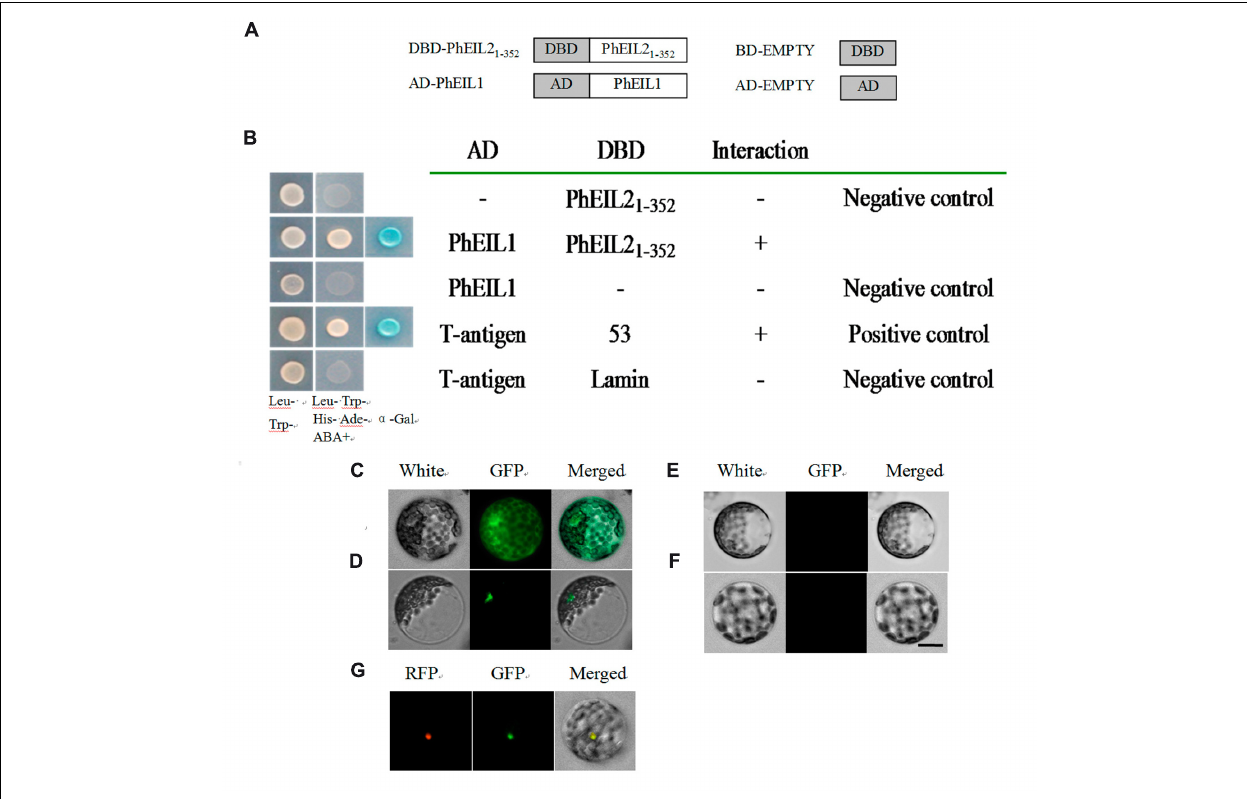
FIGURE 7 | Interaction between PhEIL2 1 − 352 and portions of PhEIL1. (A,B) Yeast two-hybrid assays between PhEIL2 1 − 352 and portions of PhEIL1. (A) Portions of PhEIL2 and PhEIL1 were fused to DBD and AD, respectively; (B) interaction between PhEIL2 1 − 352 and PhEIL1. Gold Y2H yeast strains were co-transformed with DBD–PhEIL2 1 − 352 and PhEIL1. The ability of yeast cells to grow on synthetic medium lacking tryptophan, leucine, histidine, and adenine but containing 125 µ M Aureobasidin A as well as turn blue in the presence of the chromagenic substrate X- β -Gal was scored as a positive interaction. Yeast cells transformed with pGBKT7-53 + pGADT7-T, pGBKT7–PhEIL2 1 − 352 + pGADT7-T, pGBKT7–PhEIL2 1 − 352 + pGADT7-PhEIL1, pGBKT7 + pGADT7-PhEIL1, or pGBKT7-Lamin + pGADT7-T were included as positive or negative controls. C-F, BiFC assays between PhEIL2 and PhEIL1. Translational fusion constructs of the coding region of PhEIL2 to pSAT-YFC and the coding region of PhEIL1 to pSAT-YFN were transferred into petunia protoplasts and tested for fluorescence complementation. (C) pSAT-GFP; (D) YFC-PhEIL2 and YFN-PhEIL1; (E) YFC-PhEIL2 and pSAT-YFN; (F) pSAT-YFC and YFN-PhEIL1. (G) YFC-PhEIL2, YFN-PhEIL1, and RFP-EOBII. Three biological replicates do these results represent in (G) . Images of (C–F) were captured with a confocal laser scanning system. Scale bars: 5 µ m.